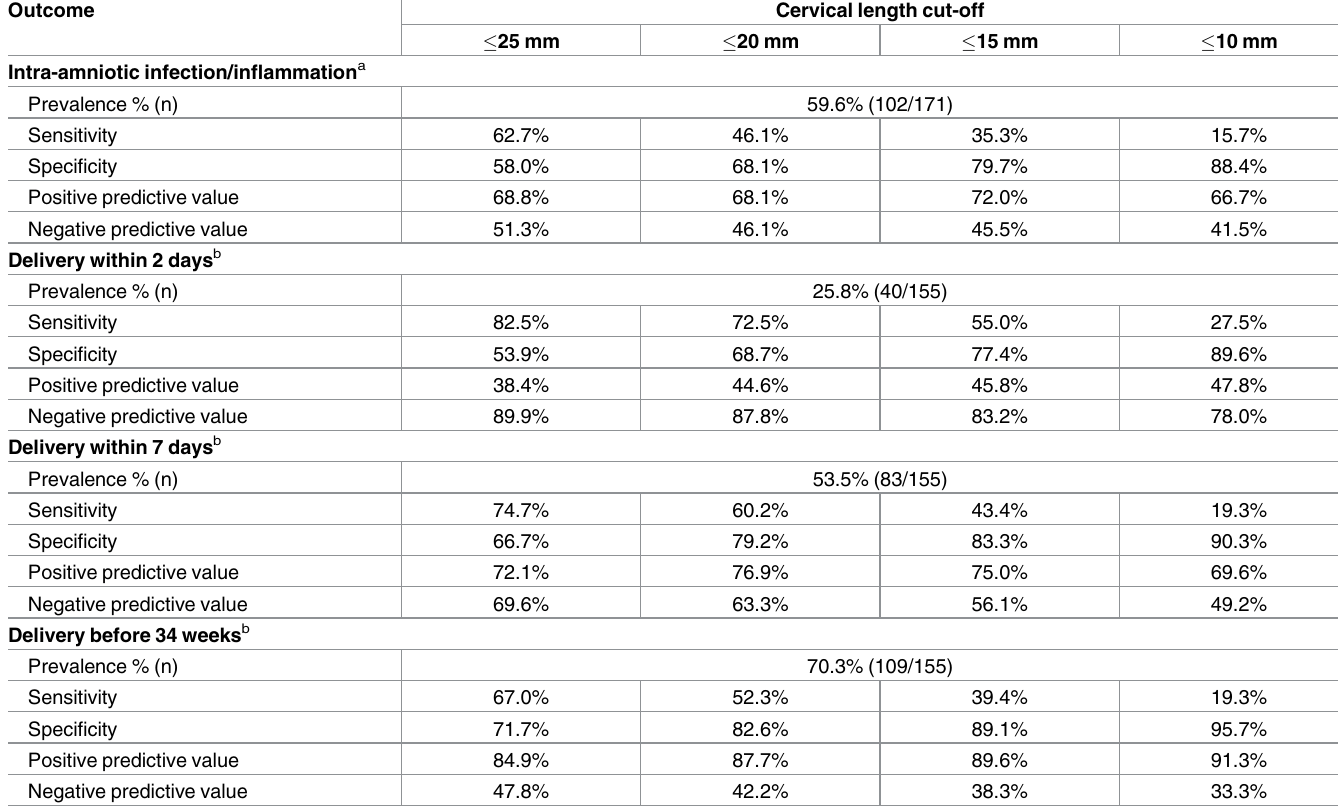
Table 4. Comparison of different cut-off values for cervicallength in predicting intra-amniotic infection/inflammation and preterm birth.